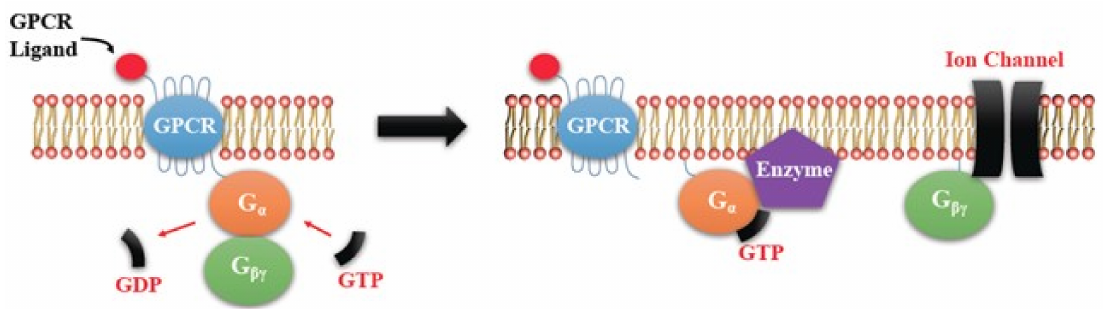
Figure 2. Heterotrimeric G-protein activation and inactivation cycle. The activation occurs by conversion of G-protein alpha (G α )-coupled guanosine diphosphate (GDP) to Guanosine-5 (cid:48) -triphosphate (GTP). The activated G-protein then dissociates into an α and a β / γ complex. GTP bound G α is active. Intrinsic GTPase activity leads to the inactivation of the G-Protein. GDP bound G α re-associates with a β / γ complex to form the inactive G-protein that can again associate with a